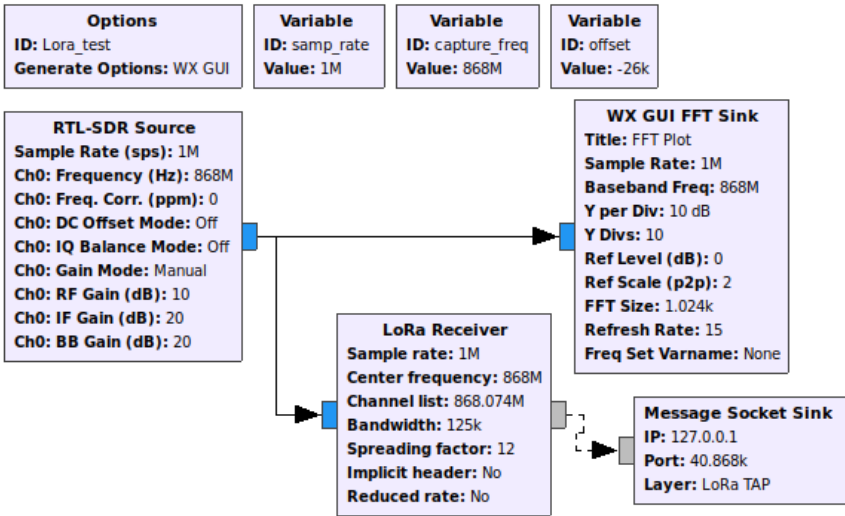
Figure 8. GNU Radio configuration for eavesdropping a LoRa-encoded packet.